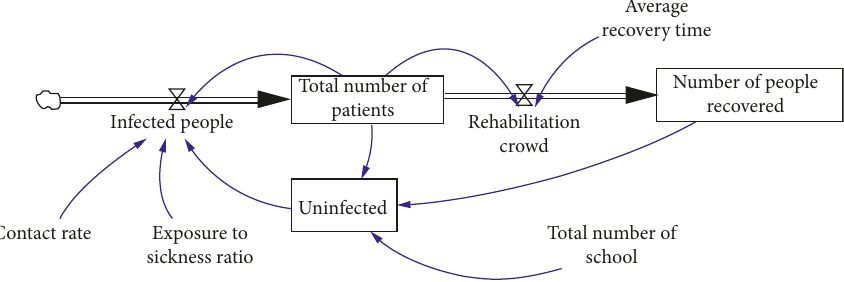
Figure 5: Logical framework diagram of an infection in the second